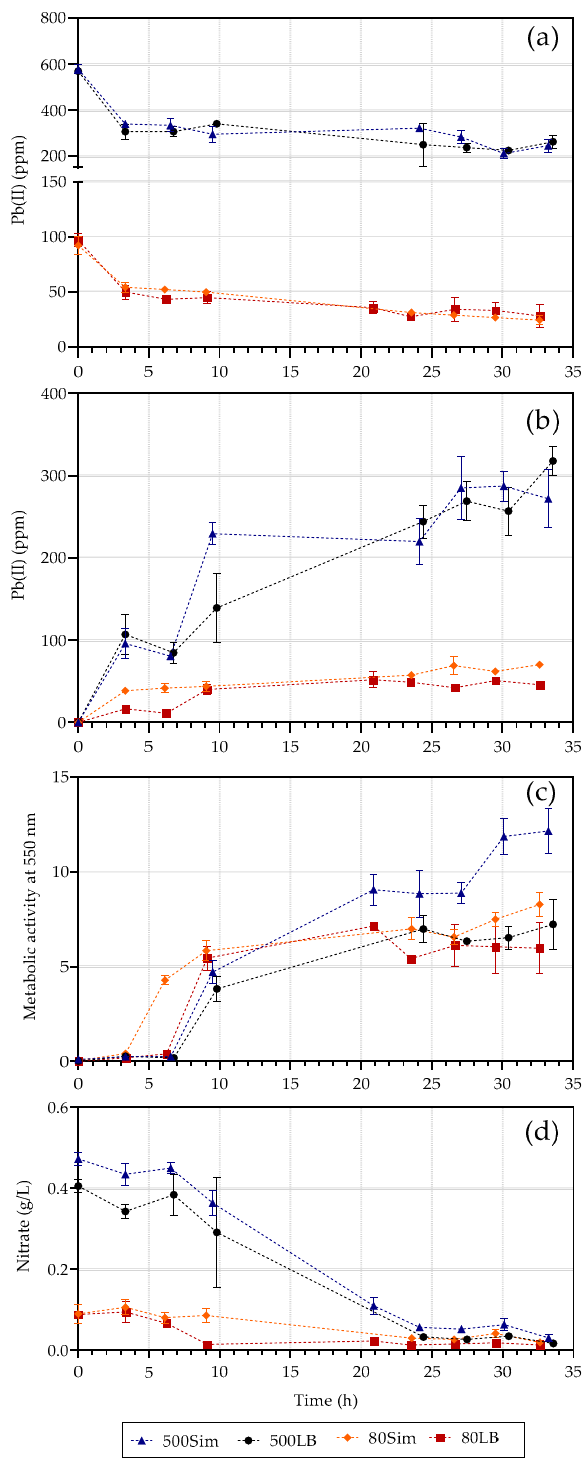
Figure 1. Pb(II) measurements in the supernatant ( a ) and precipitate ( b ), growth ( c ) and nitrate ( d ) measurements with time, adapted from [9].